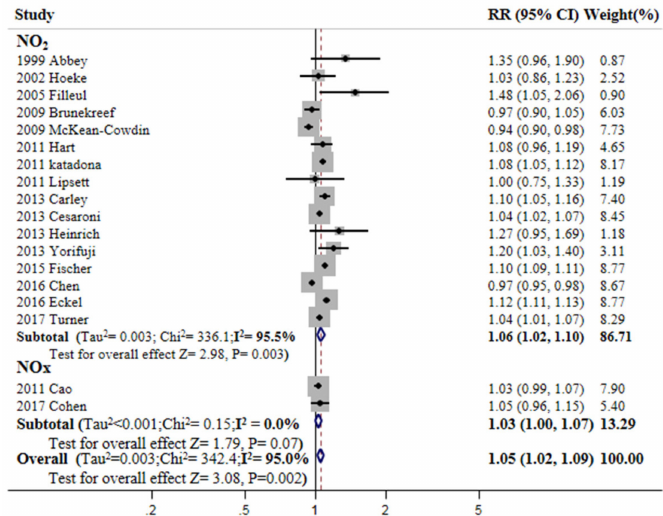
Figure 3. Mortality from cancer according to long-term exposure to nitrogen dioxide (NO 2 ) and nitrogen oxides (NO x ) in a random-effects meta-analysis of observational studies. RR, relative risk; CI, confidence interval (RR and 95% CI are for a 10 µ g/m 3 increase in NO 2 and NO x